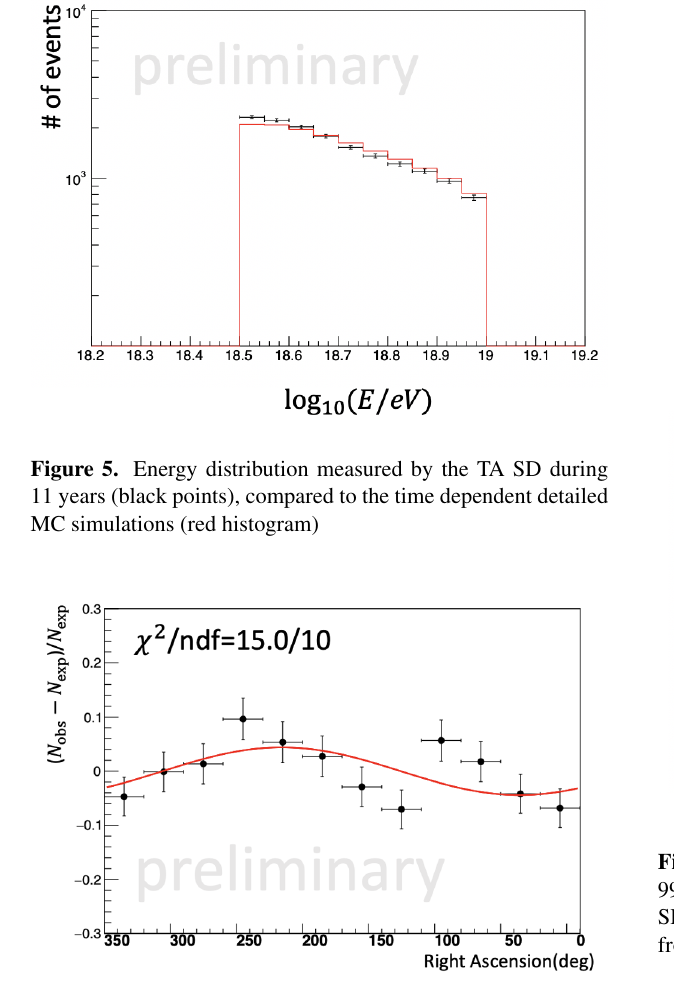
Figure 6. Residual intensities vs right ascension analyzed from 11-years of TA SD data of residual intensities. The red curve shows a fitted result by r α cos( α + ϕ α )